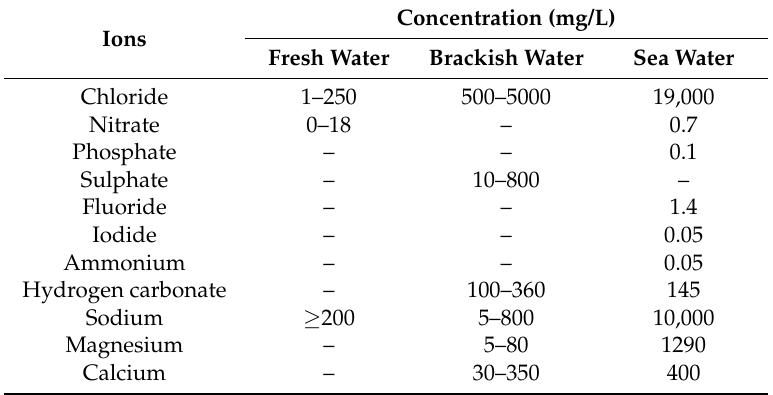
Table 4. A comparison of the concentration ranges of mineral ions present in fresh and saline water